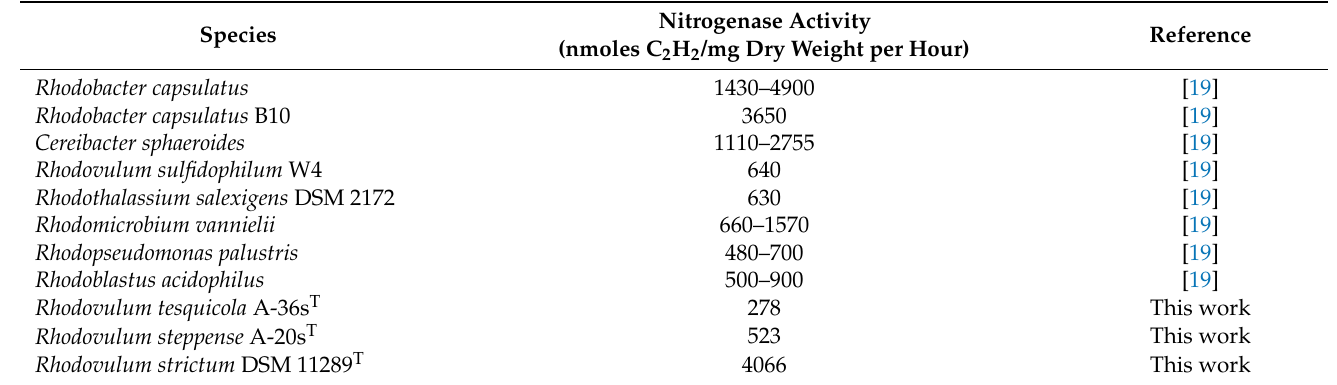
Table 3. Nitrogenase activity in the pure cultures of anoxygenic phototrophic Alphaproteobacteria (strain designation is indicated in case if only one strain was